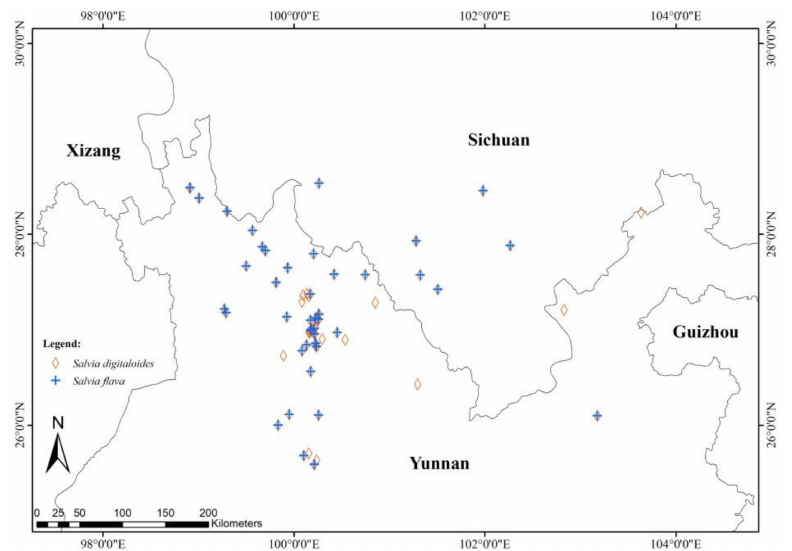
Figure 1. Geographic location of Salvia digitaloides (coral diamond, n = 40) and the S . flava (crosshair blue, n = 59) in Yunnan and Sichuan provinces of China. Geographic distribution ranges of the two species are based on localities in herbarium specimen records in the Chinese Virtual Herbarium, the Chinese National Specimen Information Infrastructure, and the website Global Biodiversity Information